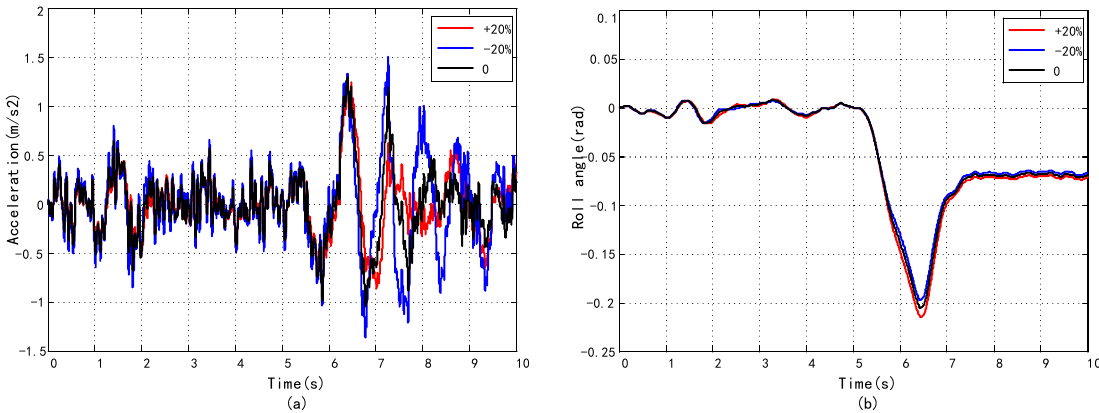
Figure 17. The robustness simulation curves with uncertainty of unspring mass: ( a ) the vehicle body vertical acceleration in time domain; ( b ) the roll angle acceleration in time domain.